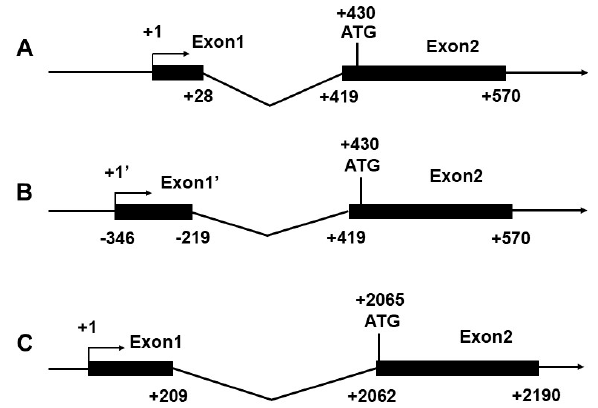
Figure 1. A map of the first two exons in the CPT I α 1b and CPT I α 2a genes was shown. Exons were denoted by black rectangles , introns by a fold line and transcriptional direction (5 ′ -3 ′ ) by an arrow line. The initiation codon (ATG) in exon 2 represented the start site of protein translation. Numbers were relative to the distance from transcription start site (+1). ( A ) structure of transcription start site (TSS) of CPT I α 1b gene ( B ) structure of alternative splicing transcription start site (TSS’) of CPT I α 1b gene ( C ) structure of transcription start site of CPT I α 2a gene.